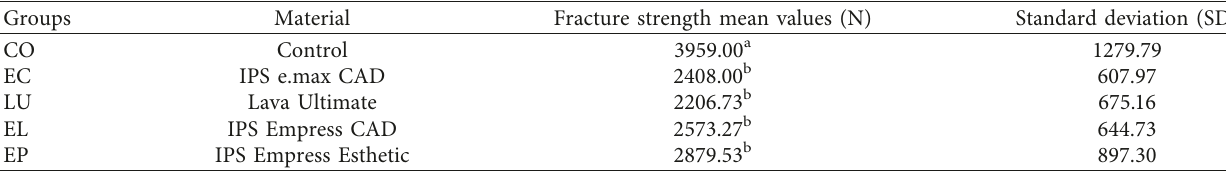
Table 3: Mean fracture resistance values, standard deviations, and statistical categories of all experimental groups ( n � 15). Groups